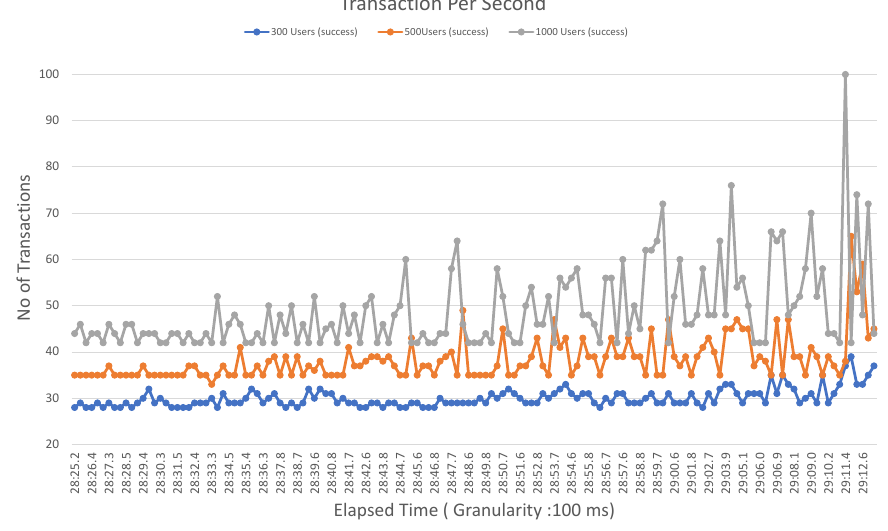
Figure 10. Transaction Per Second